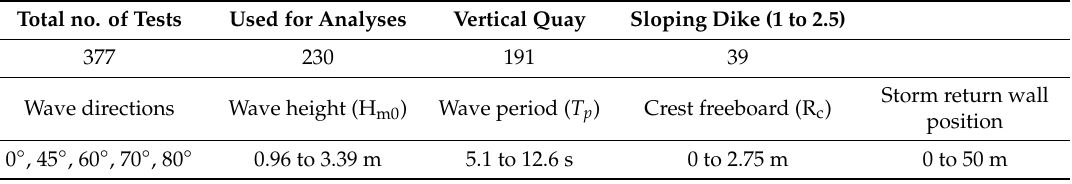
Table 3. Summary of the test conditions for overtopping reduction.